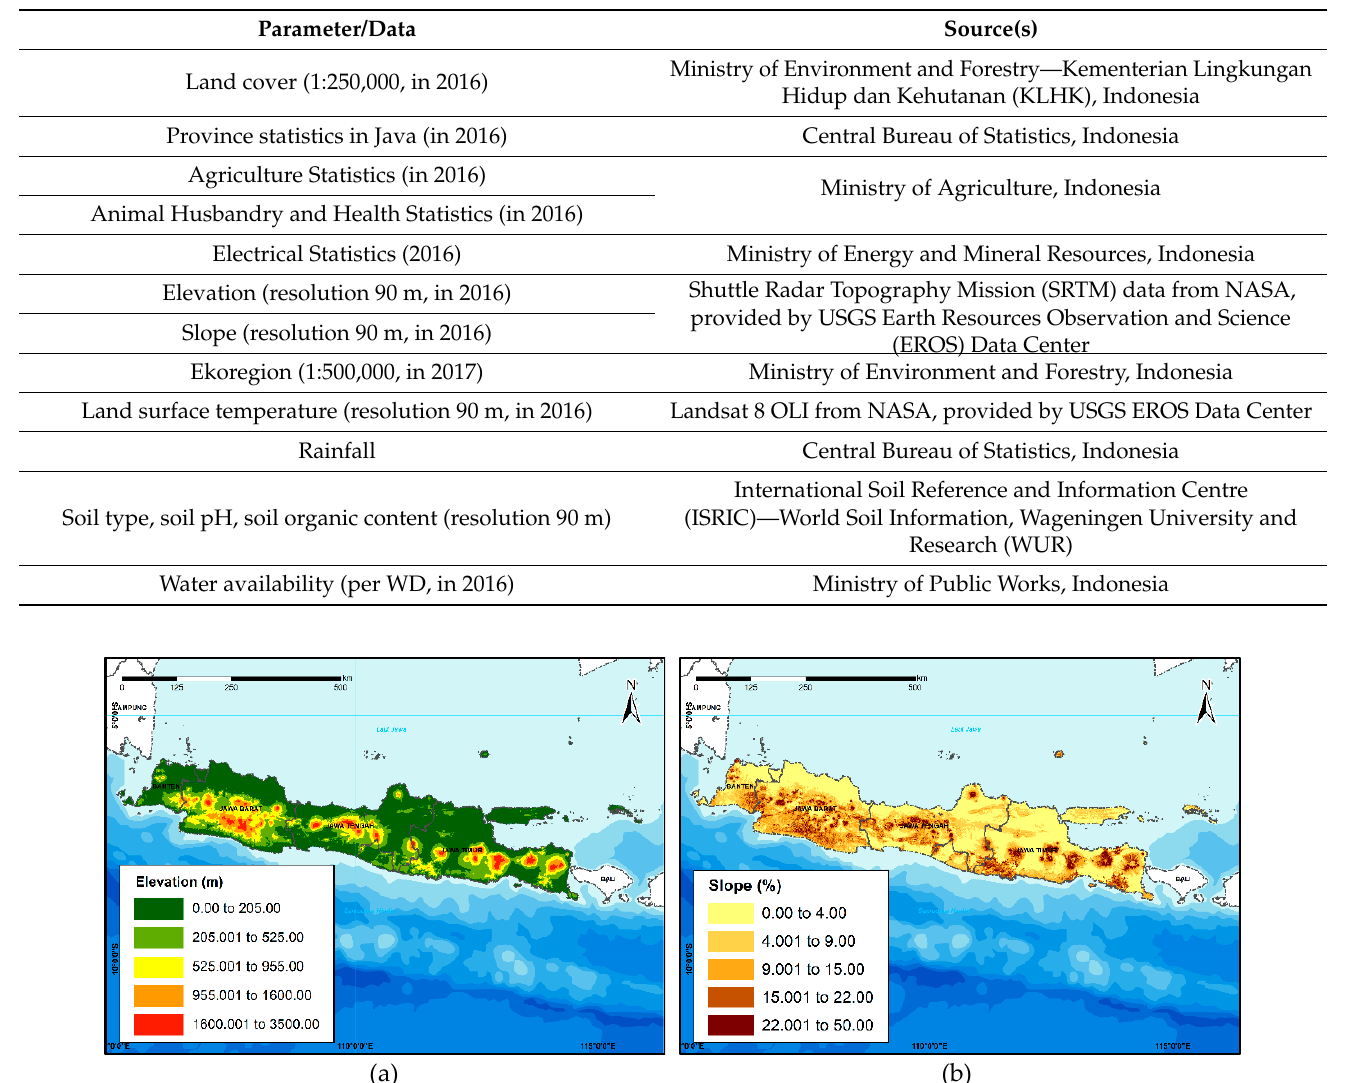
Table 1. Secondary data to calculate spatial allocation based on physiological needs and land suitability.